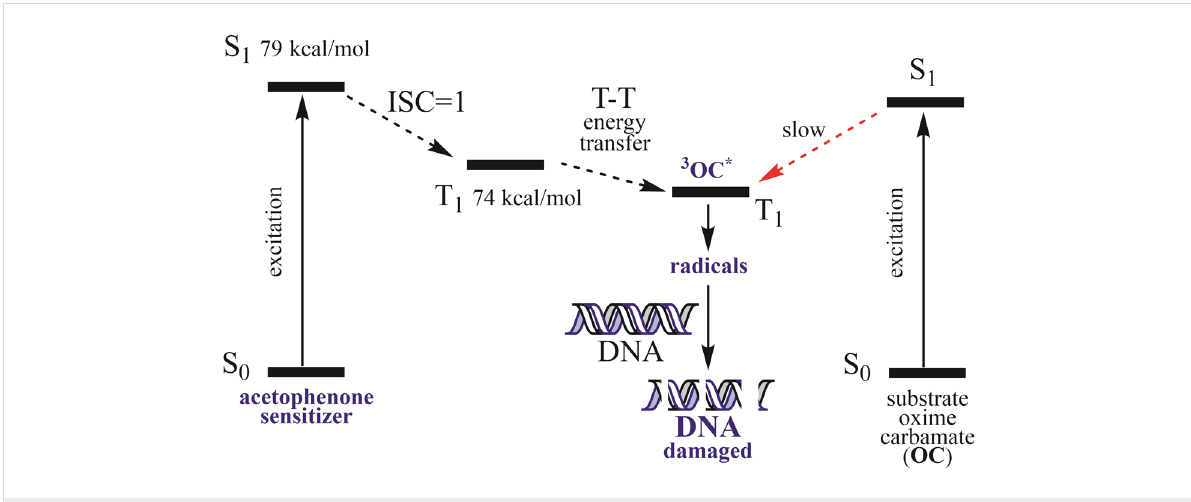
Figure 7: Proposed scheme showing a possible energy transfer from acetophenone sensitizer to oxime carbamate substrate.